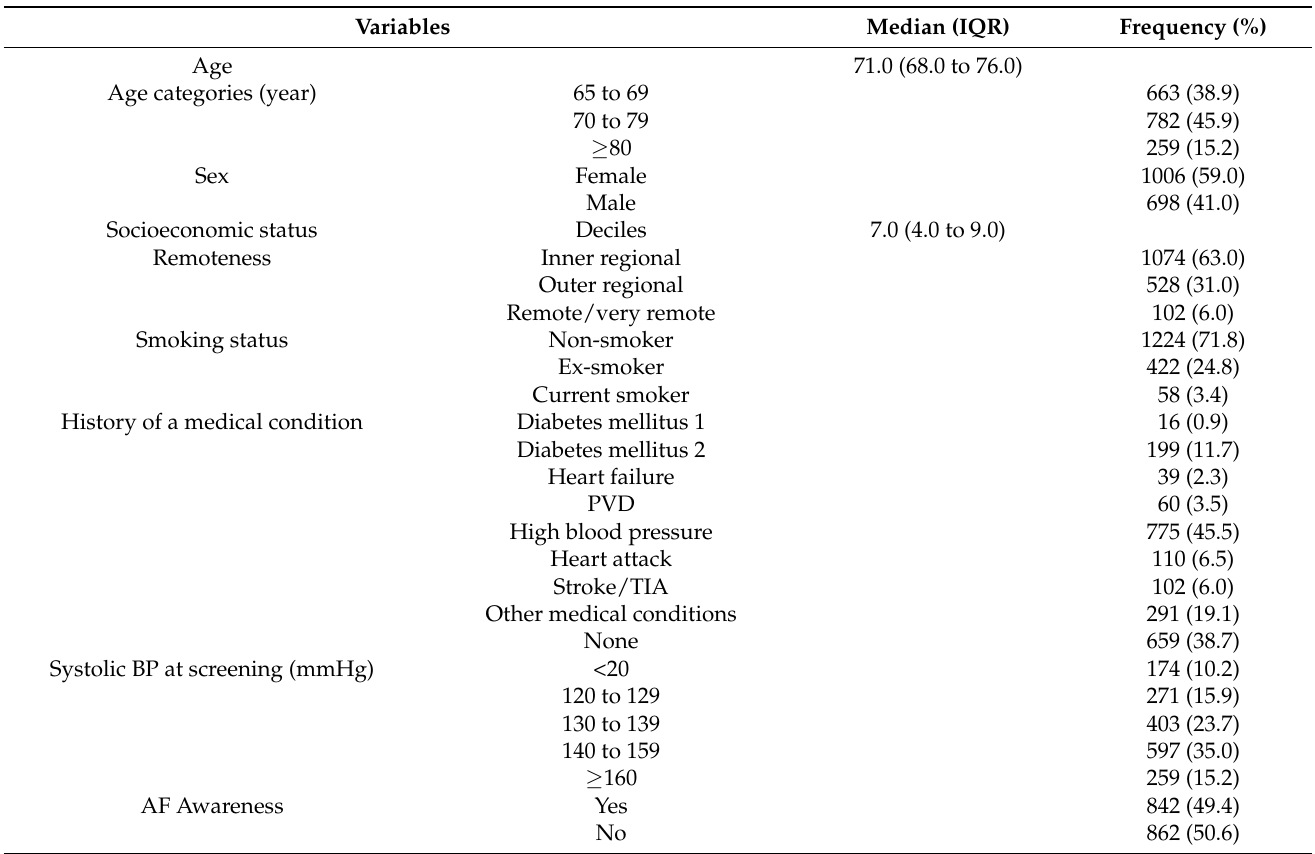
Table 2. Characteristics of the study participants ( n =